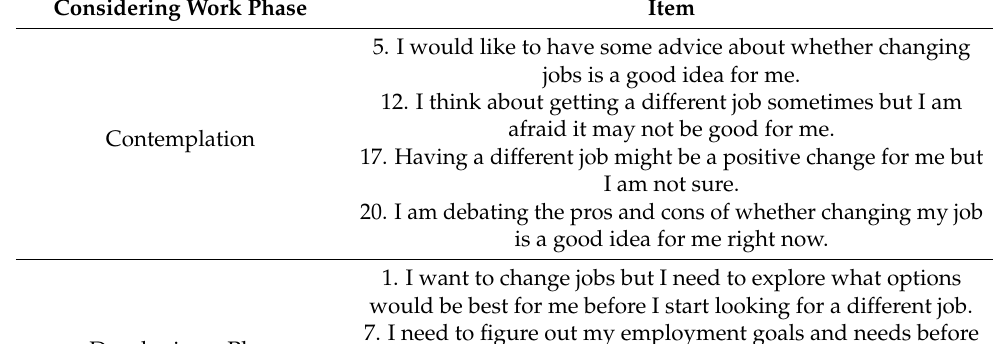
Table 2. Considering Work Scale-Employed